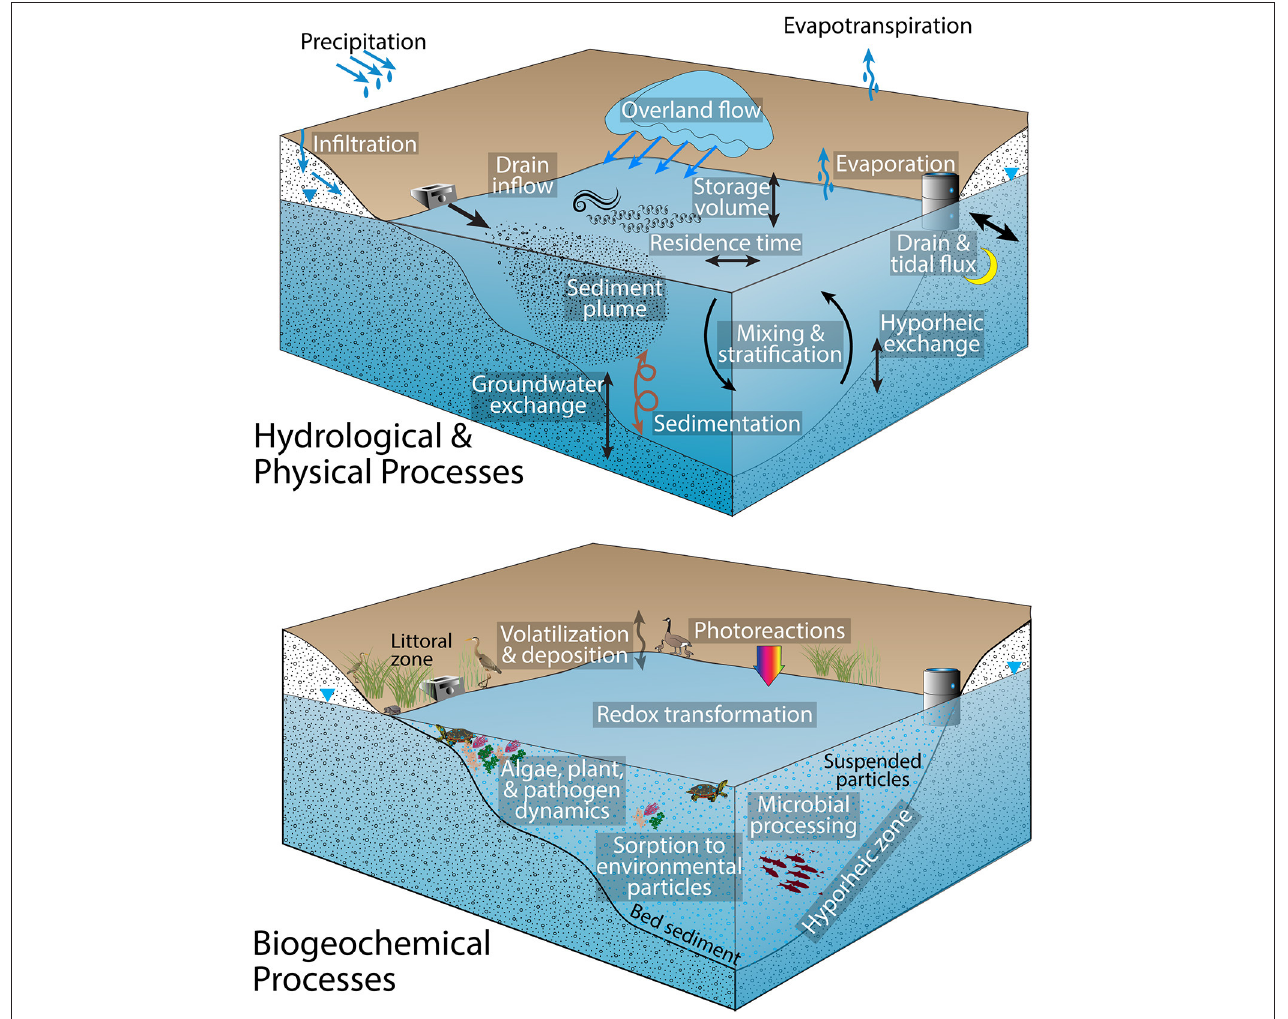
FIGURE 3 | Conceptual model outlines hydrological and physical (upper), and biogeochemical processes (lower) that occur in stormwater ponds. The hydrological and physical processes reflect a typical hydrologic cycle as well as stormwater runoff and associated sediment and contaminant transport. The biogeochemical processes reflect various consumption, sequestration, and transformation pathways of contaminants in stormwater ponds. (Acknowledgment: some elements of this conceptual model are courtesy of the Integration and Application Network, University of Maryland Center for Environmental Science,